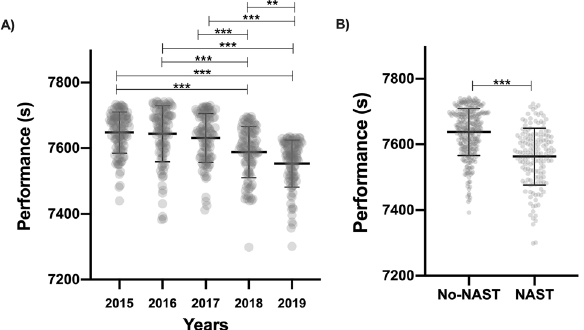
Figure 1. Distribution of the individual and average finishing times from the top-100 performances per year from 2015 to 2019 (A) . Distribution of the individual performances and average times from runners with and without NAST (B) . **p ≤ 0.01; ***p ≤